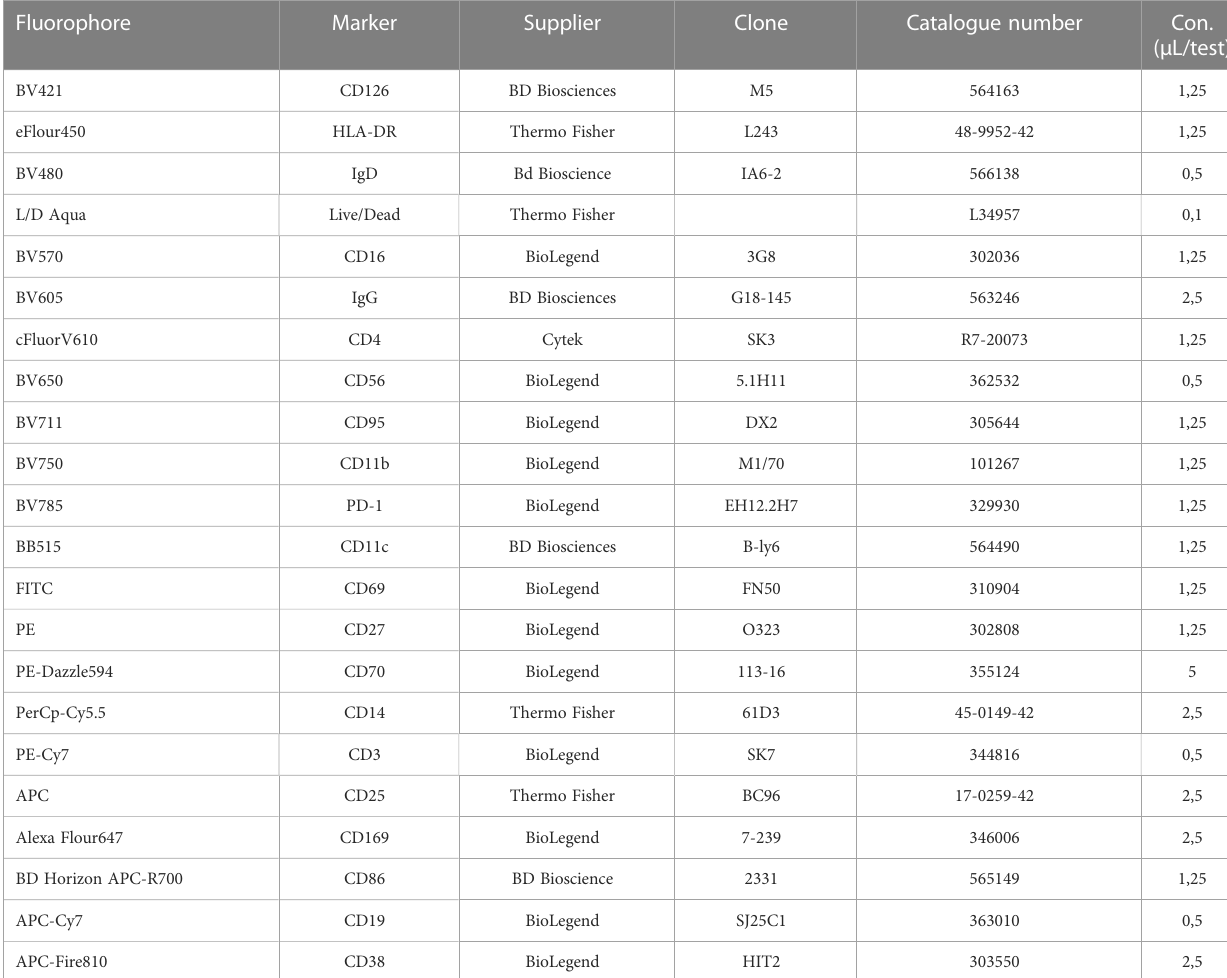
TABLE 3 Reagents and dilutions used for the PBMC